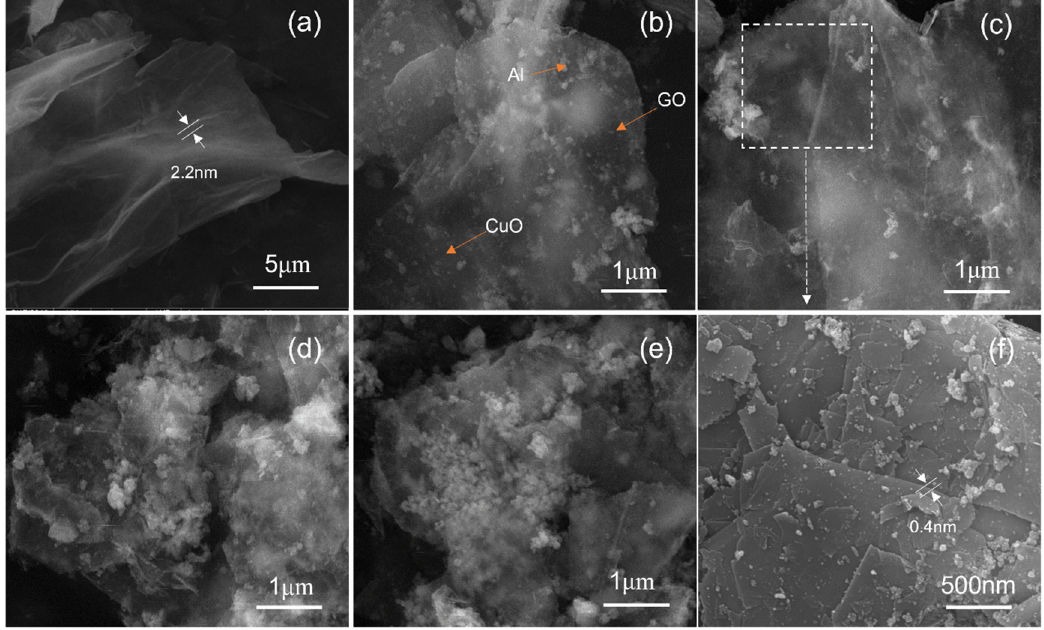
Figure 2. SEM images of Al–CuO/GO nanocomposites: ( a ) GO, ( b ) CuO:Al = 2.5:1, ( c ) CuO:Al = 2:1, ( d ) CuO:Al = 1.5:1, ( e ) CuO:Al = 1:1, and ( f ) a partially enlarged image.